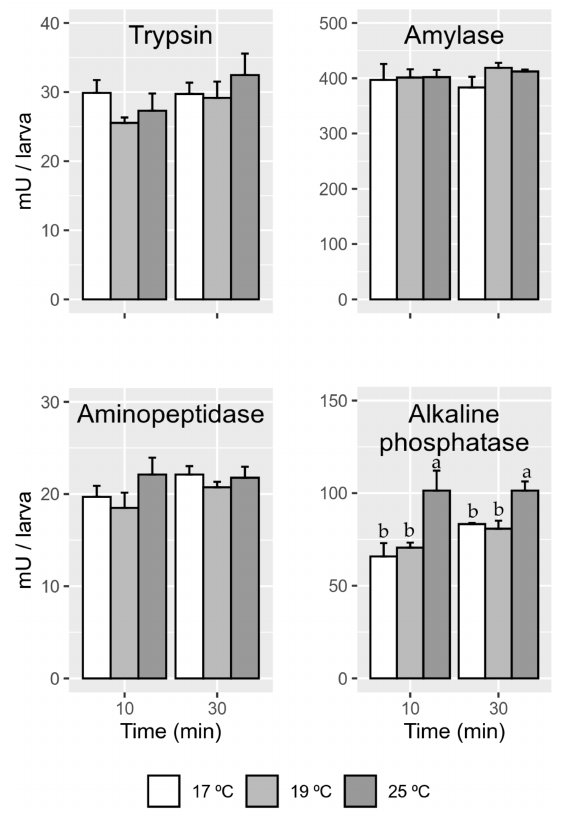
Figure 8. Digestive enzyme activities in Sparus aurata larvae, 10 and 30 min after being fed at different water temperatures at 41 days post-hatching (DPH). Different letters represent significant differences among temperatures (two-way ANOVA—temperature, time, temperature ∗ time). Values represent mean ±